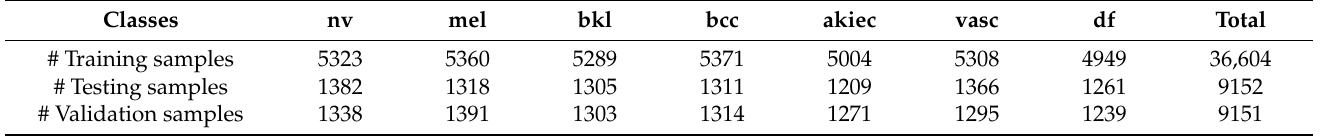
Figure 3. Class-wise count of images after balancing. Table 2. Distribution of skin lesions in train and testing